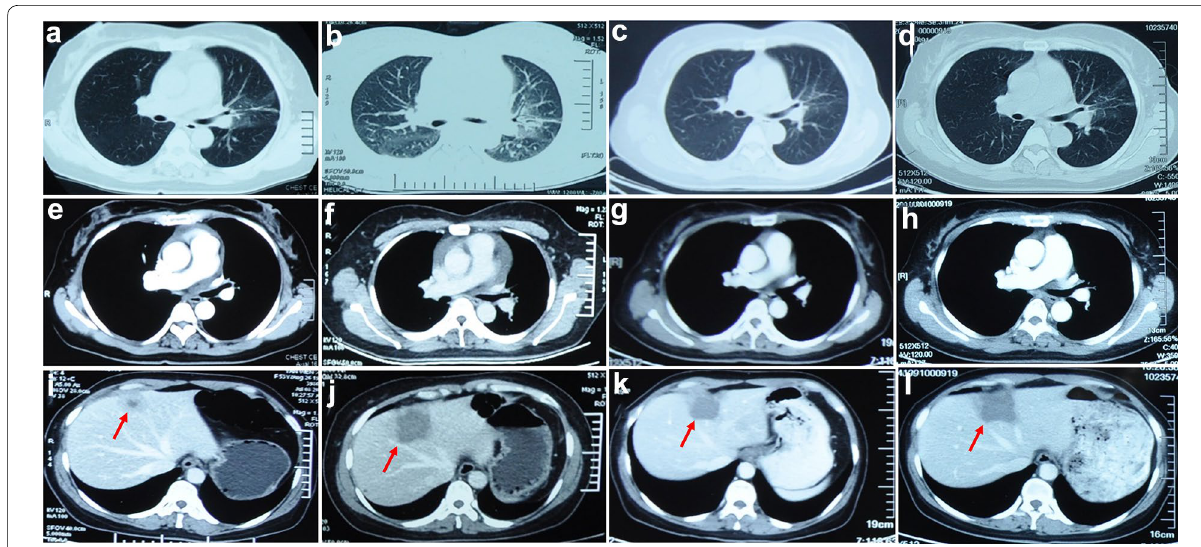
Fig. 5 Disease evaluation during the treatment of crizotinib and ceritinib. a – h The CT scan revealed complete remission of lung lesions. i A single liver nodule was found after the 6 months of starting crizotinib. j The enlarged liver lesions was revealed on 20 Aug. 2014. k The liver metastasis shrinked after the treatment of ceritinib. l The liver lesions enlarged again after the 5 months of starting ceritinib